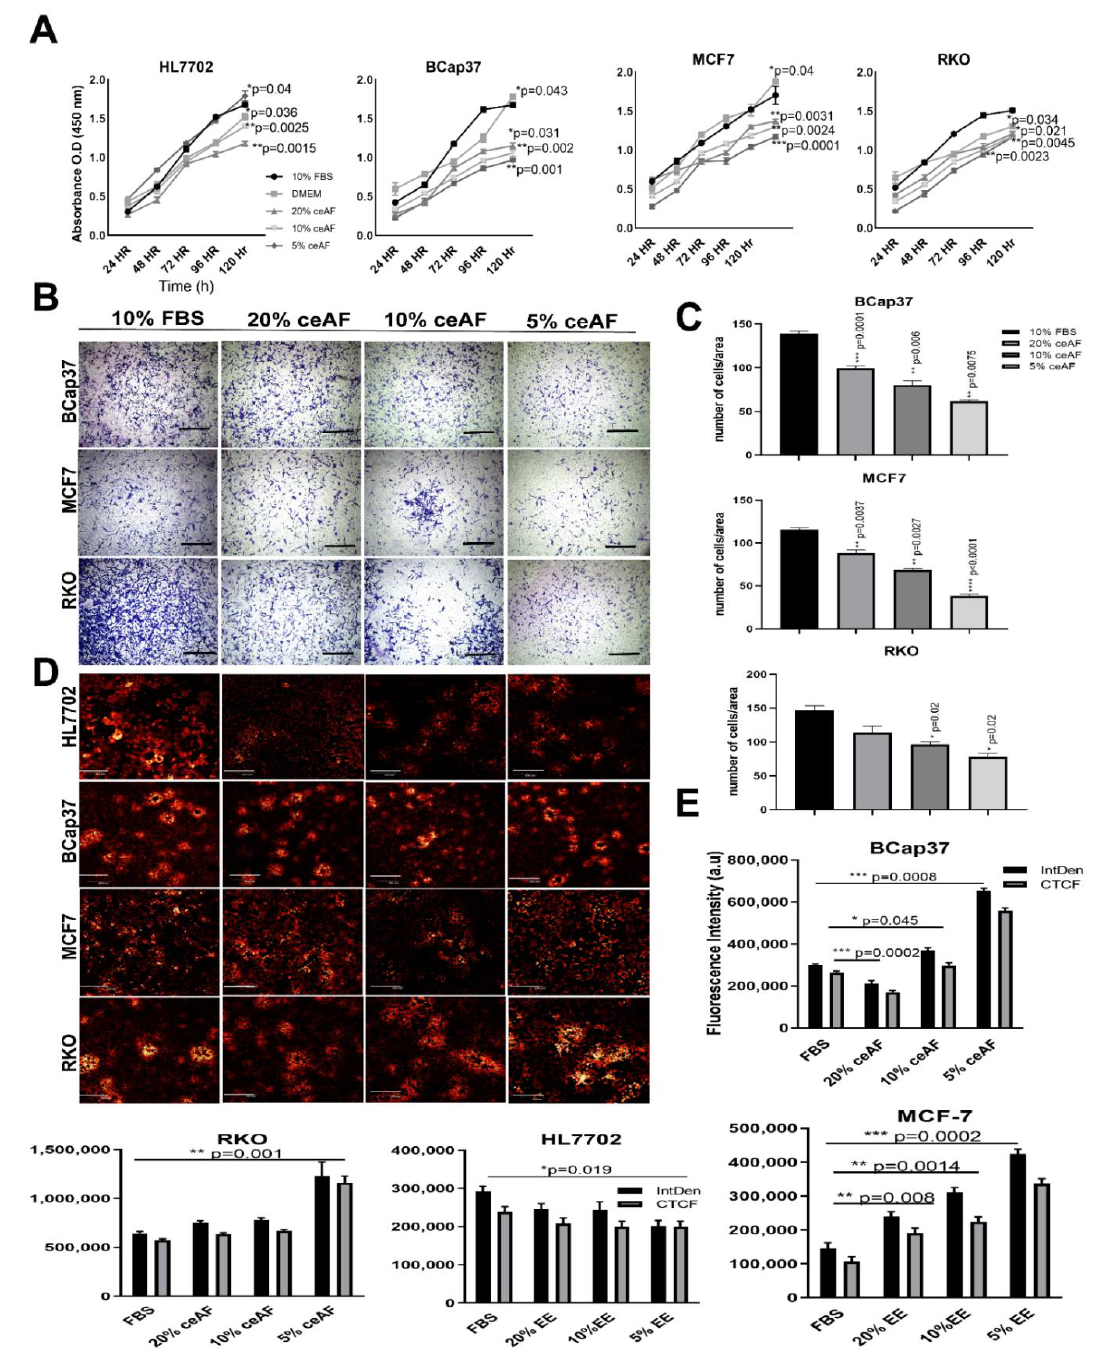
Figure 1. ceAF significantly downregulates tumor cells’ proliferation and growth via